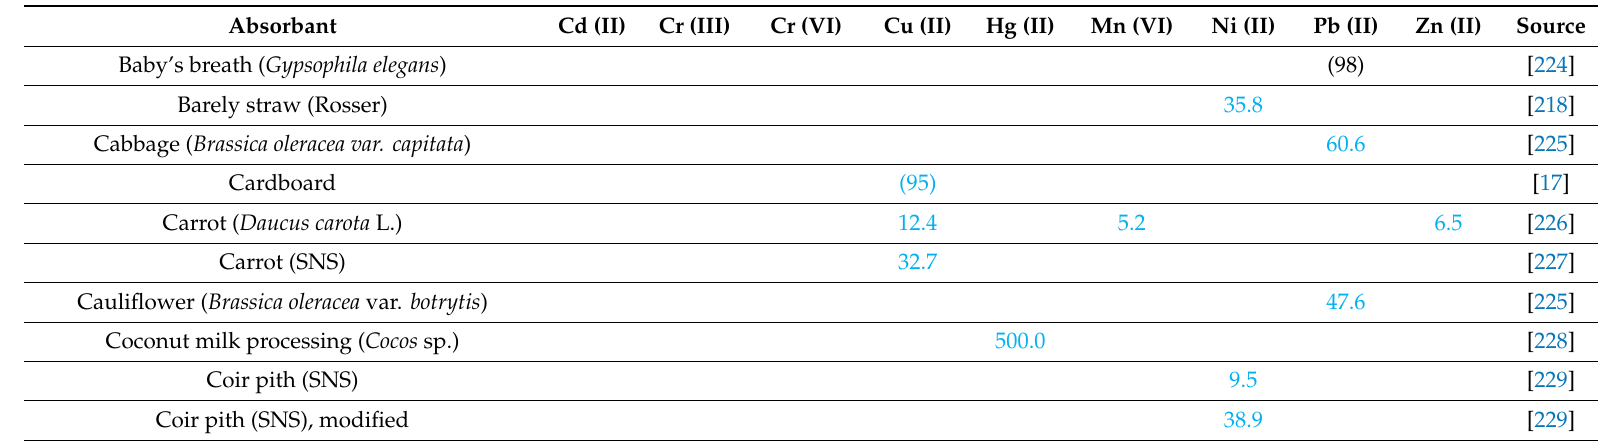
Table 4. Heavy metal removal potential using other agricultural and processing materials in the developing world, in mg / g or (% removal) (Peruvian studies in black color). SNS stands for “species not